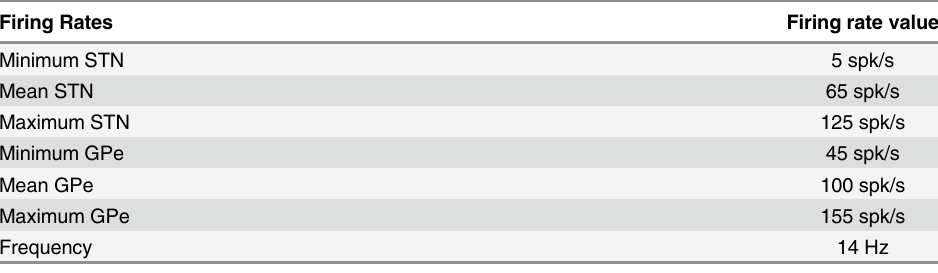
Table 2. Summary of experimental data used to constrain the model. This includes the minimum, mean and maximum firing rates of the STN and GPe populations and the frequency of pathological